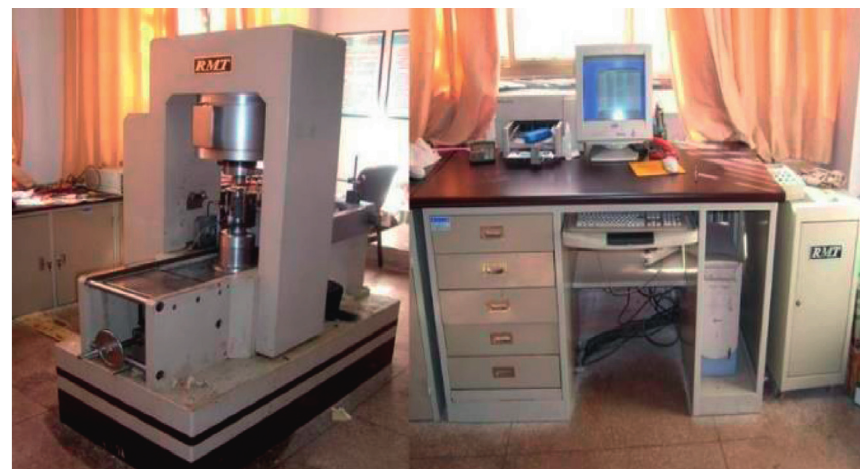
Figure 5: The RMT-150B electrohydraulic servo rock test system.